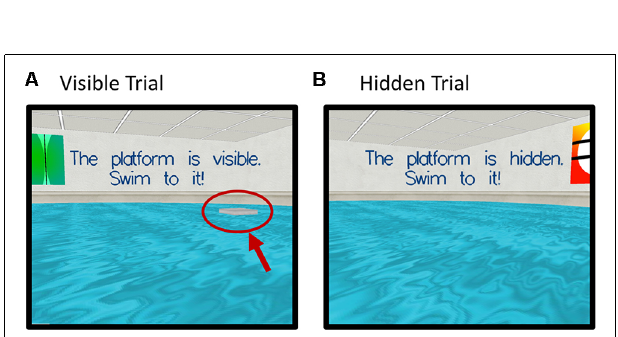
FIGURE 2 | Screenshots of the virtual Morris Water Maze Task (vMWM) which was presented to the participants on a computer screen. Panel (A) depicts a trial where the platform is visible (red arrow and circle were added retrospectively and are not part of the actual display). Panel (B) depicts a trial where the platform is hidden